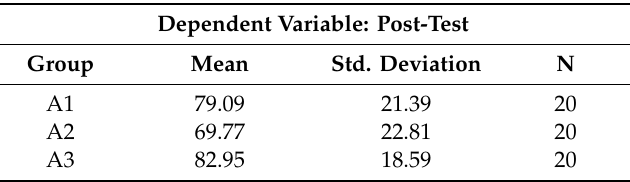
Table 2. Descriptive Statistics of groups A1, A2, and A3.